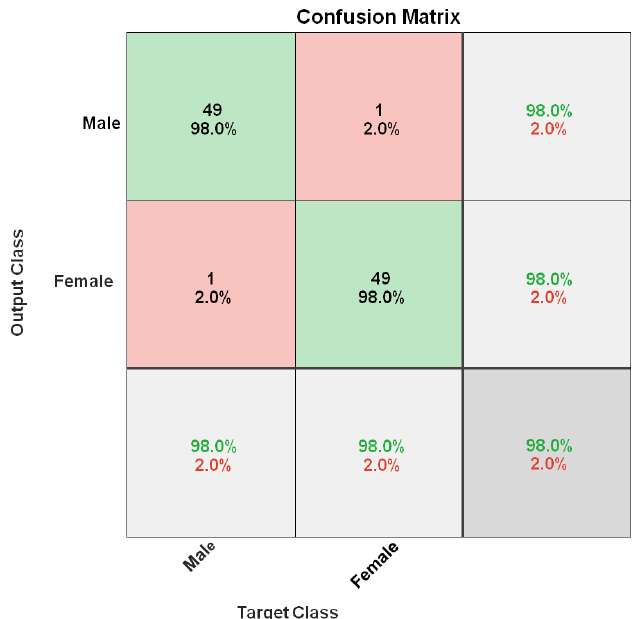
Figure 7. Confusion